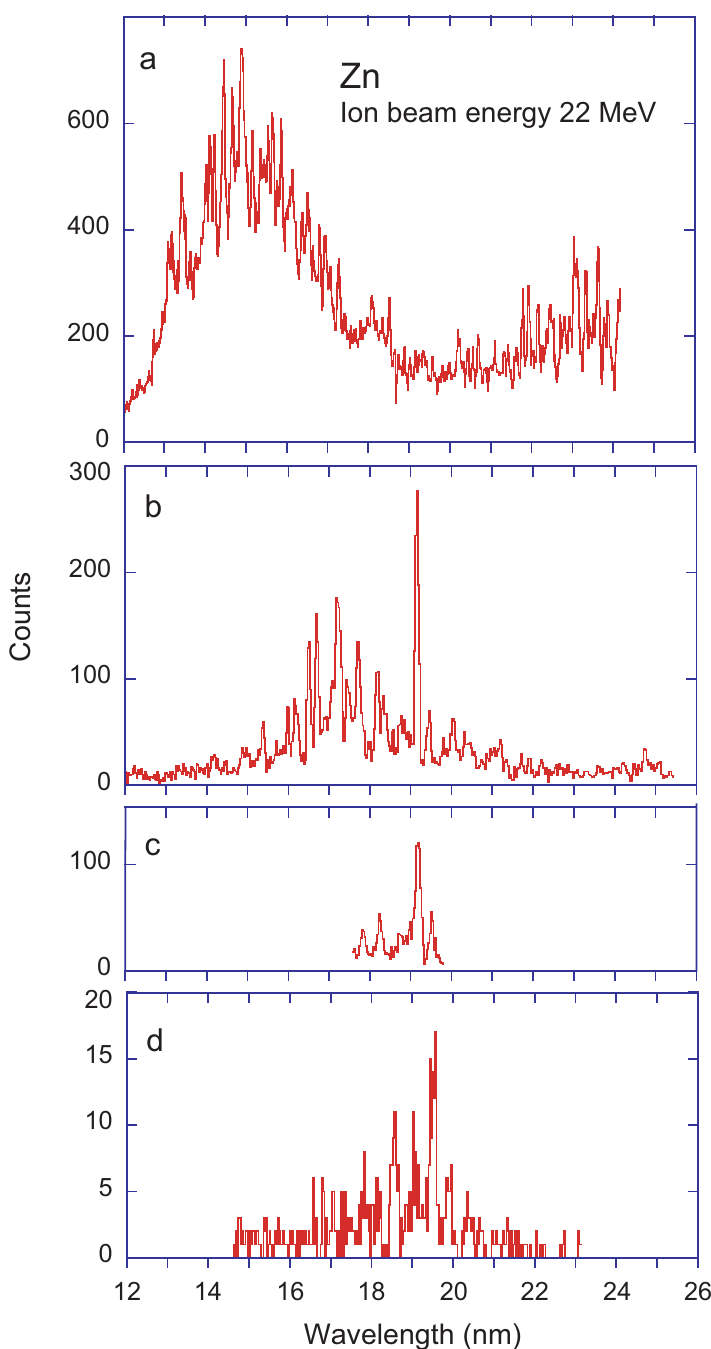
Figure 28. Beam-foil spectra of Zn at an ion beam energy of 22MeV. Observation ( a ) at a position close the foil (no delay), line width (FWHM) 0.06nm; ( b ) 20 mm downstream (delay 2.5ns), line width (FWHM) 0.09nm; ( c ) 100 mm downstream (delay 12.5ns), line width (FWHM) 0.12nm; ( d ) 175 mm downstream (delay 19ns), line width (FWHM)